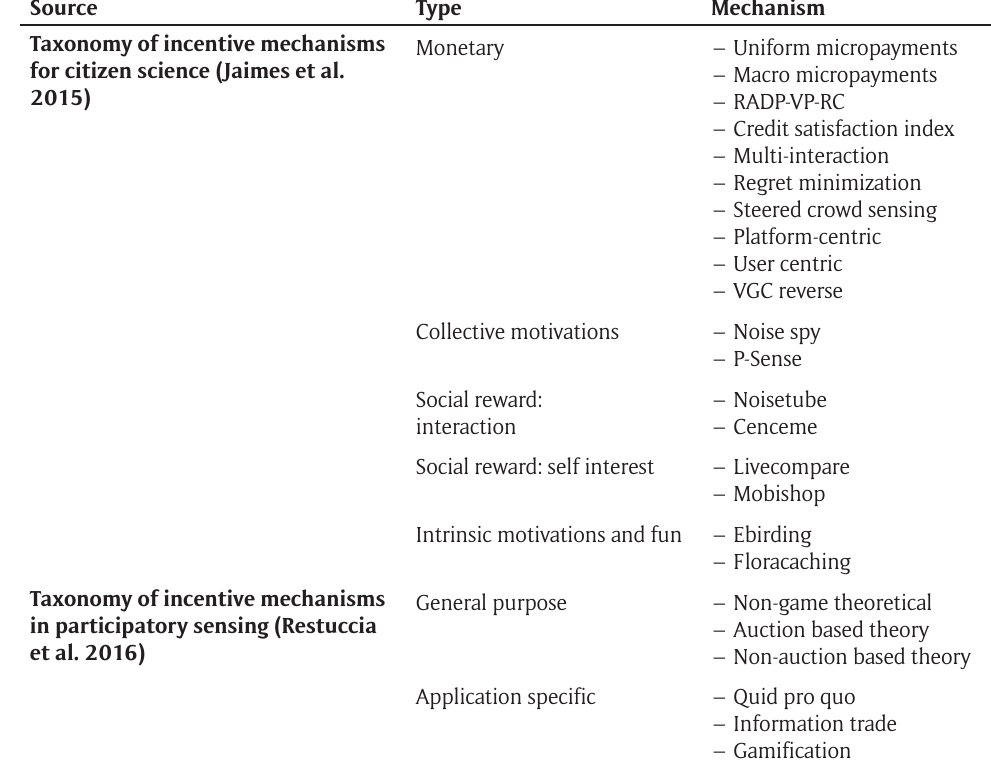
Table 1: Taxonomies of incentive mechanisms in digital citizen science/participatory sensing.